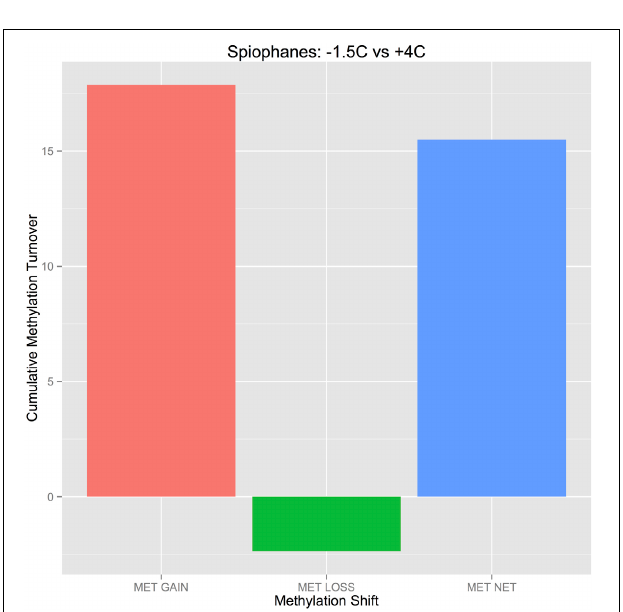
FIGURE 7 | Total magnitude of CpG site-specific changes in response to + 4 ◦ C temperature treatment. Bars present methylation gain, methylation loss, and the net methylation change among all CpG sites in response to warmer seawater temperatures (as a relative metric, based on the magnitudes of observed